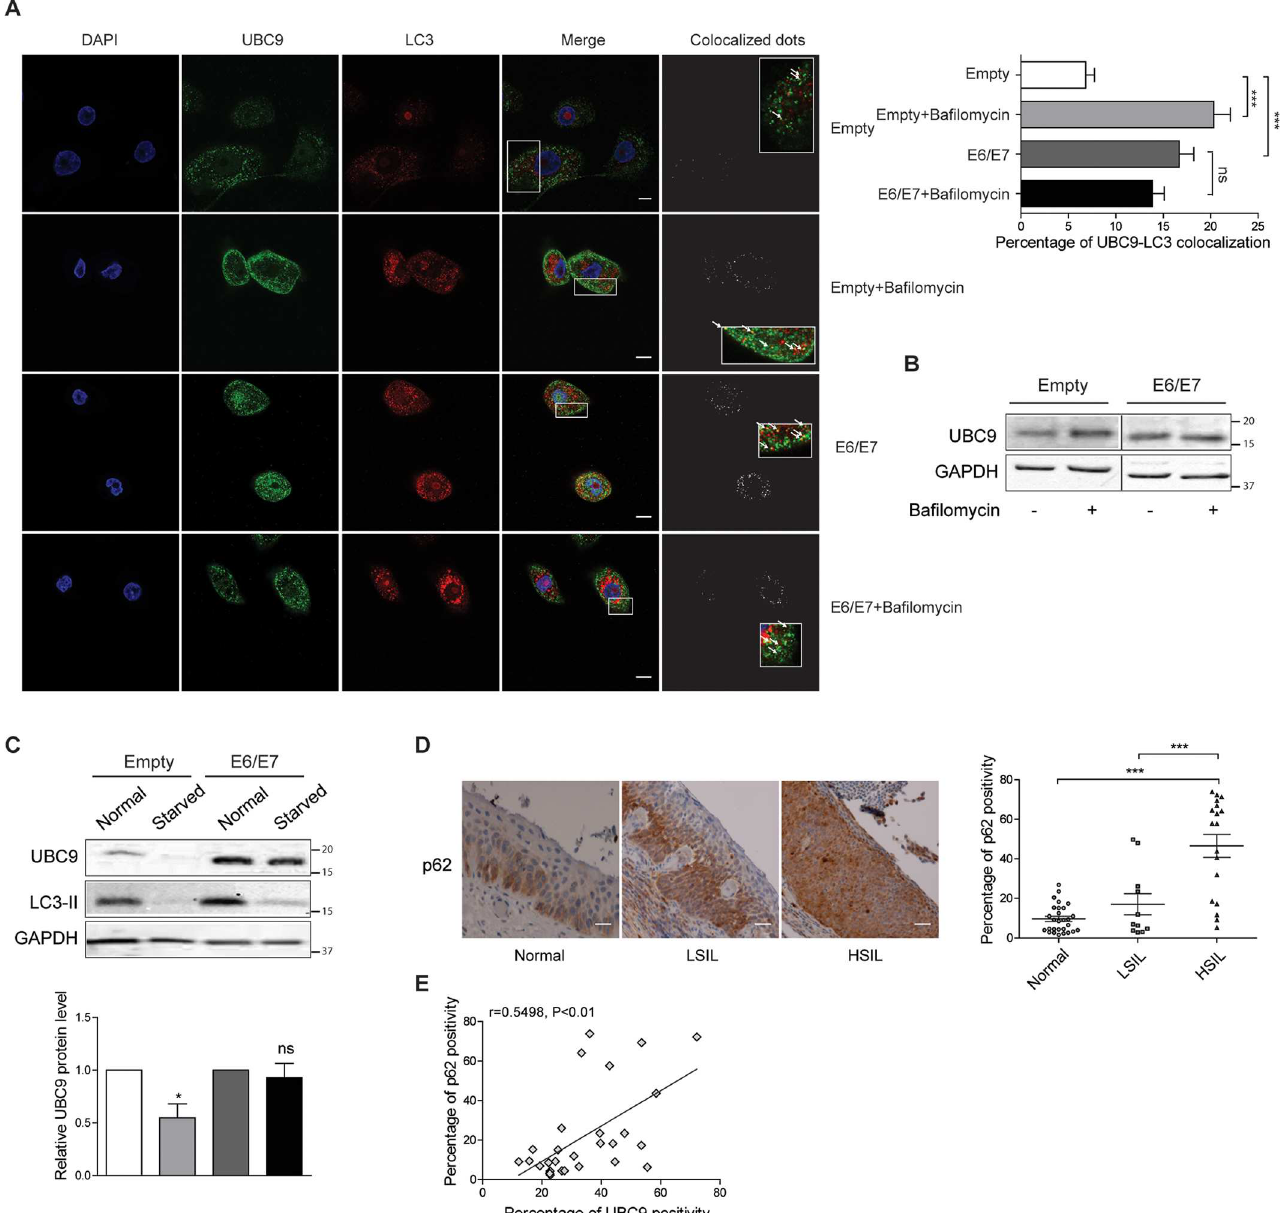
Fig 10. Late autophagic defects account for UBC9 accumulation in HPV16 E6/E7 HKs and cervicallesions. (A) Left: Confocal microscopy images of empty or HPV16 E6/E7 transducedHKs treated with vehicleor bafilomycinfor 24 hours, and immunostained with antibodyagainst UBC9 (green)and LC3 (red). Nuclei were stainedwith DAPI (blue). Colocalizeddots images show UBC9/LC3dots colocalization as determined by the Green and Red Puncta Colocalization plugin. Inset show highermagnification views of boxed regions. Arrows highlightcolocalized dots. Scale bar = 5 μ m. Right: Quantification of UBC9/LC3colocalization expressedas percentageof colocalizedUBC9 with LC3 (doublelabeleddots) dots on total UBC9 (singlelabeledplus doublelabeleddots) per cell, as determined with the Green and Red Puncta Colocalization plugin. Bars represent means ± SEM from at least 47 fields of three different biologicalreplicates. *** P < 0.0001; ns: not significant(one-wayANOVA and Bonferroni post hoc test). (B) Representative WB analysisof UBC9 expressionin cells treated as in (A). n = 3 different biological replicates. (C) Top: Representative WB analysisof empty or HPV16 E6/E7 HKs cultured in growth or in starvation medium. LC3-II disappearance was used to confirm autophagy activation[92]. Bottom: UBC9 normalizedexpressionreportedas fold over cells grown in normal medium. Bars represent means ± SEM of n = 7 different biological replicates. * P < 0.05;ns: not significant(Kruskal–Wallis one-wayANOVA with Dunn’spost hoc test) comparedto normalmedium- grown cells. (D) Left: Representative IHC images of FFPE humannormal, LSIL or HSIL cervical tissues stainedwith anti-p62antibody. Right: Percentage of p62 positive pixels in FFPE human cervical tissues. Scale bars = 200nm. Data are expressedas percentage of positive plus strong positive stainedpixels. The black lines represent the mean for each group. n = 18 (normal), 11 (LSIL), 18 (HSIL) different patients. *** P < 0.0001